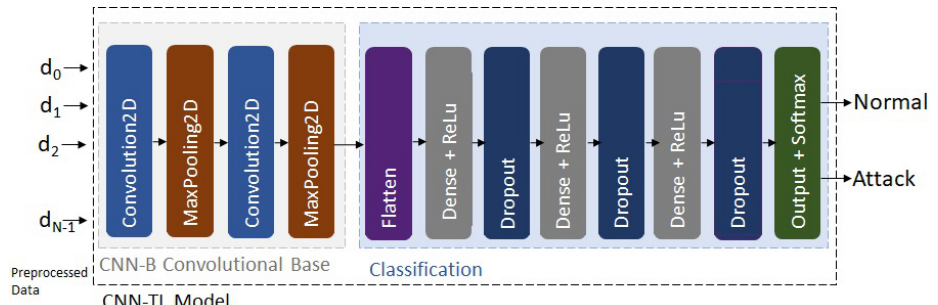
Figure 4. CNN-TL IDS-model